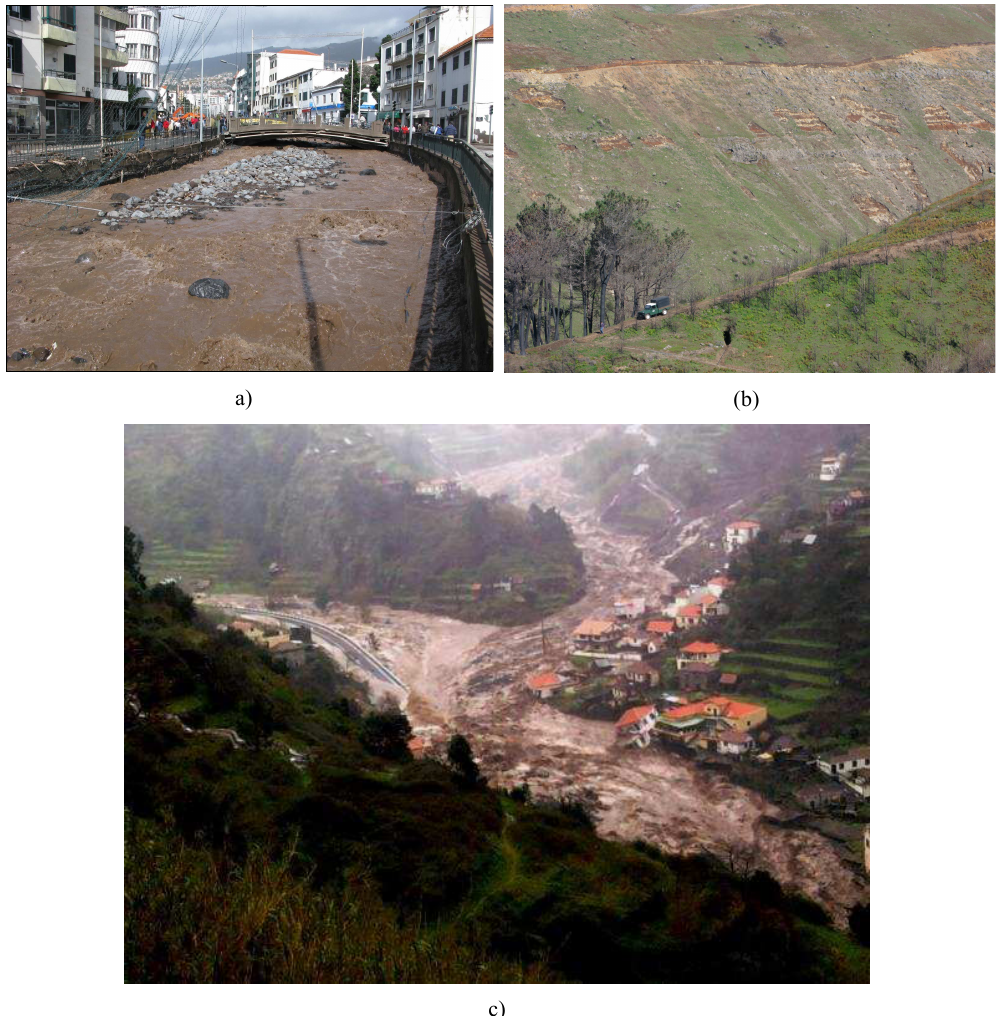
Fig. 2. Photos showing the destructive effects of the 20 February 2010 flash-floods and landslides in: (a) downtown and (b) uplands; (c) Serra de ´Agua, Ribeira